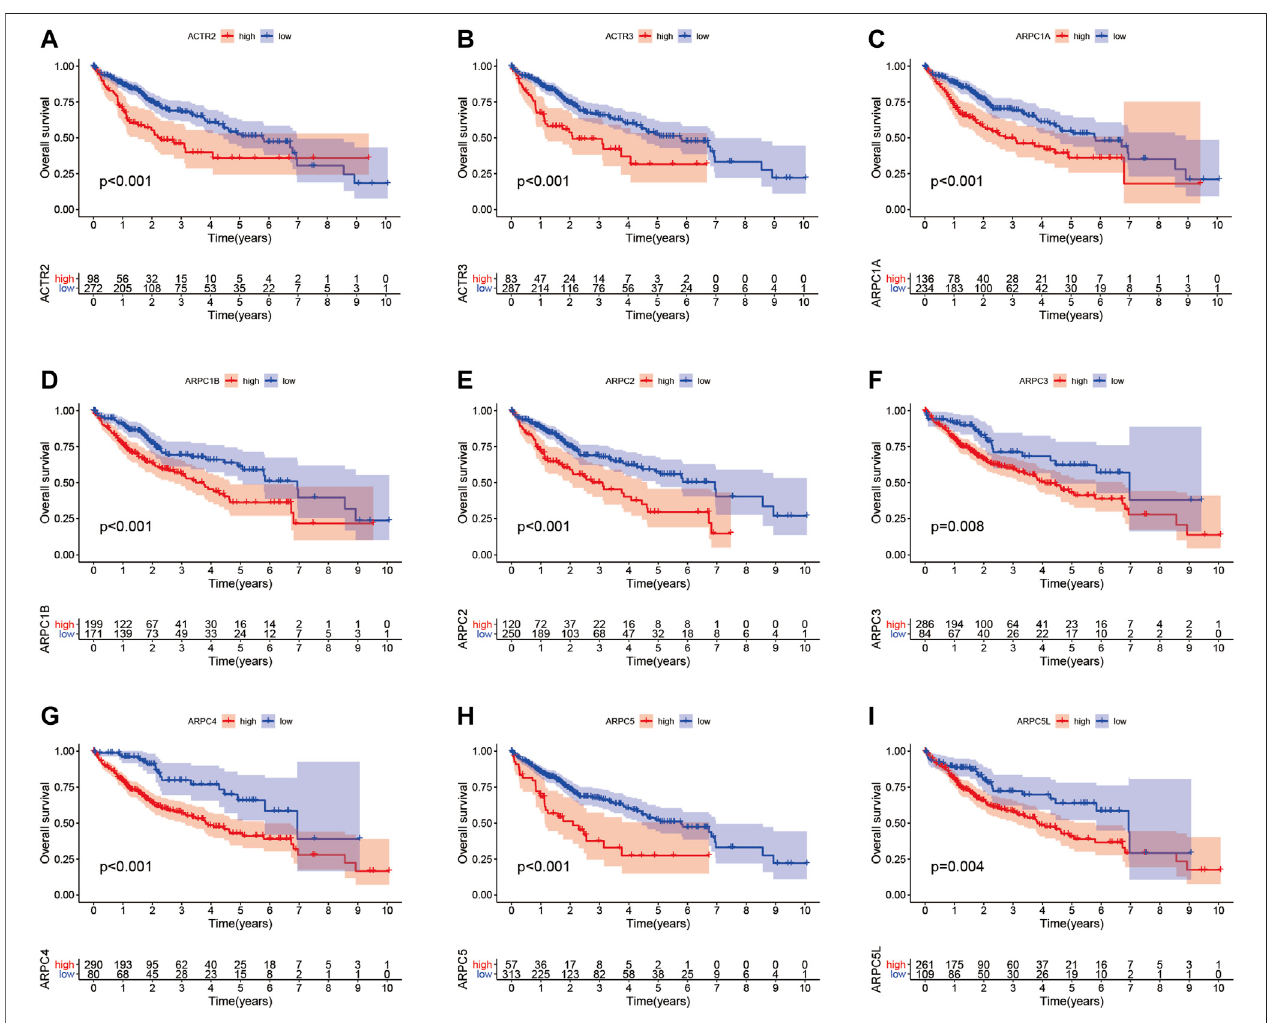
FIGURE 7 | Kaplan – Meier survival analysis of the association between mRNA expression of Arp2/3 complex members and overall survival (OS) in HCC patients (A – I) . The information of HCC samples was derived from the TCGA and UCSC Xena databases.